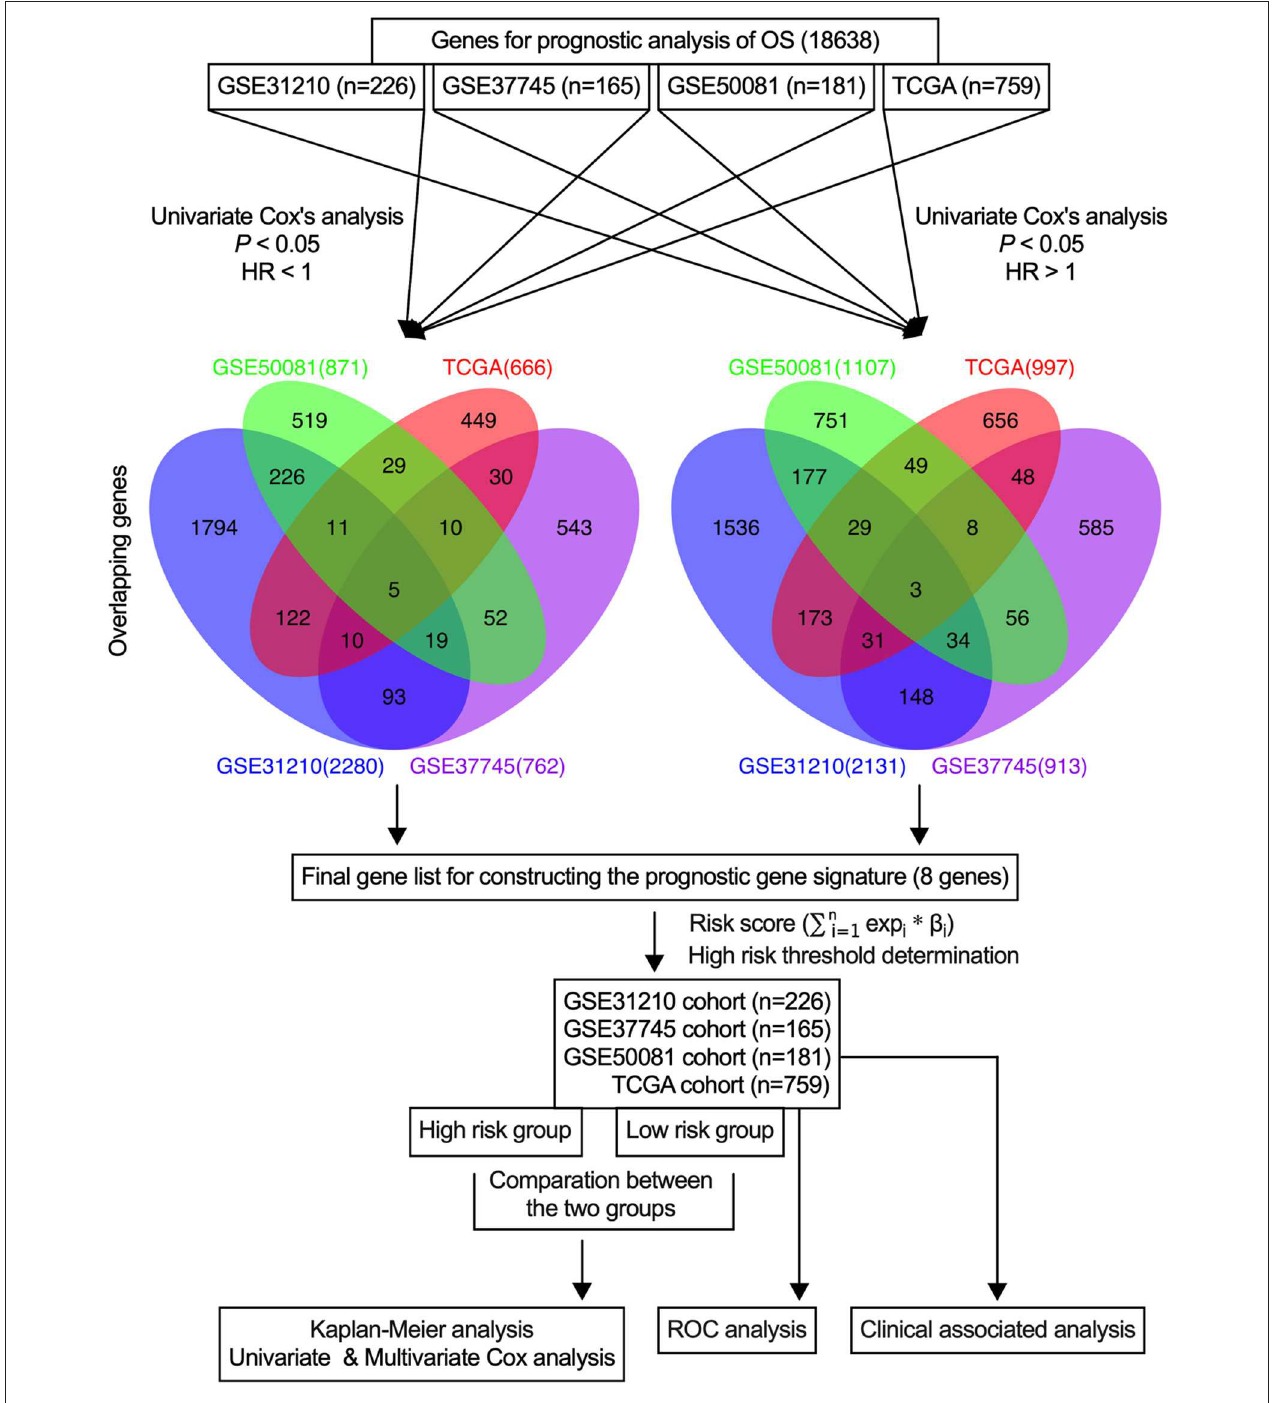
FIGURE 1 | Study flow diagram. OS, overall survival.